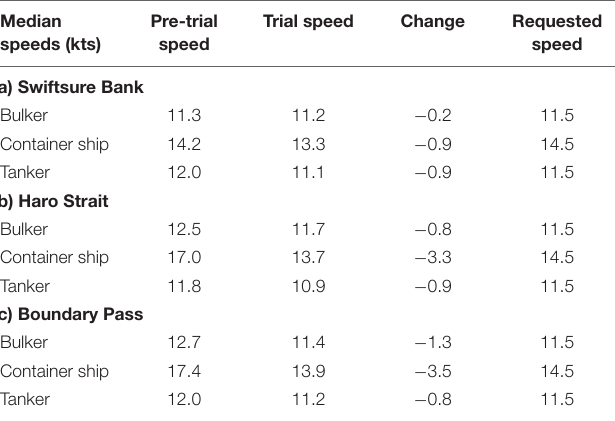
TABLE 2 | Values of median speed for pre-trial and trial periods, and median speed change between periods for slowdown regions. Median speeds